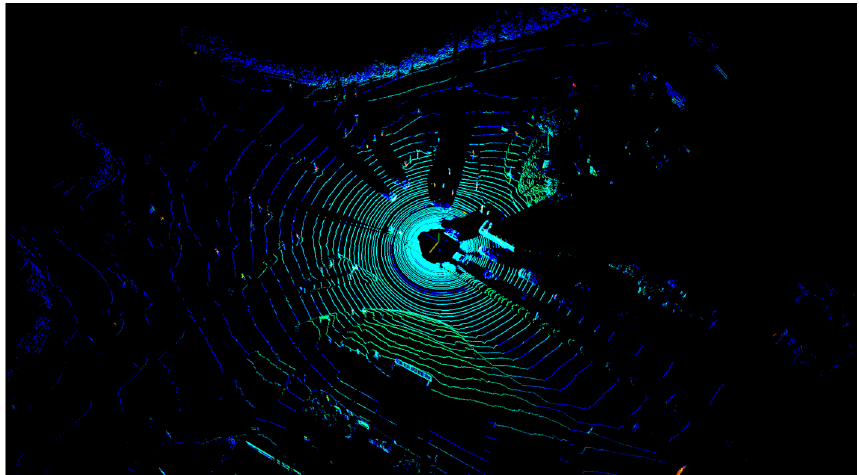
Figure 6. The example of raw point clouds in KITTI dataset.